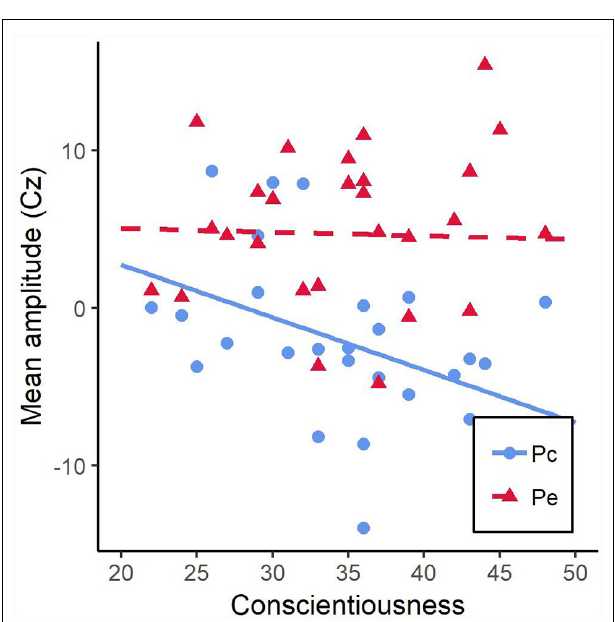
FIGURE 5 | Mean amplitudes during 200–350 ms post-response interval at electrode Cz as a function of conscientiousness for correct (Pc) and incorrect responses (Pe). The lines resulted from regressing Pc and Pe amplitudes onto conscientiousness.